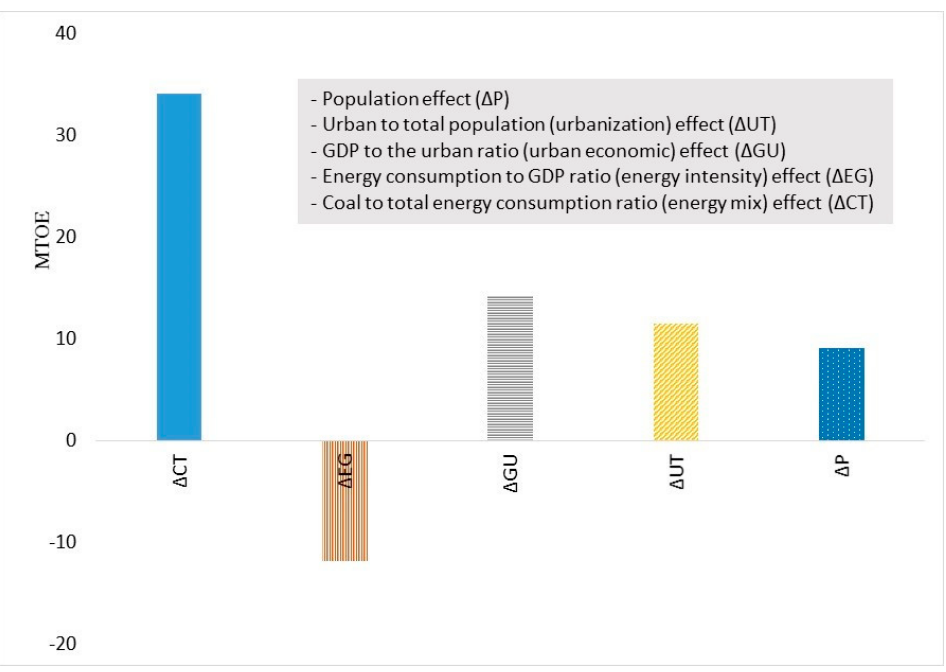
Figure 6. The accumulated effect of coal consumption drivers in Indonesia 1965–2017.